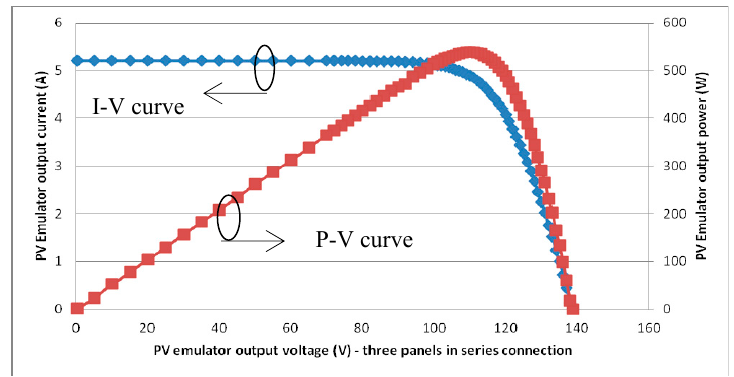
connected in series.